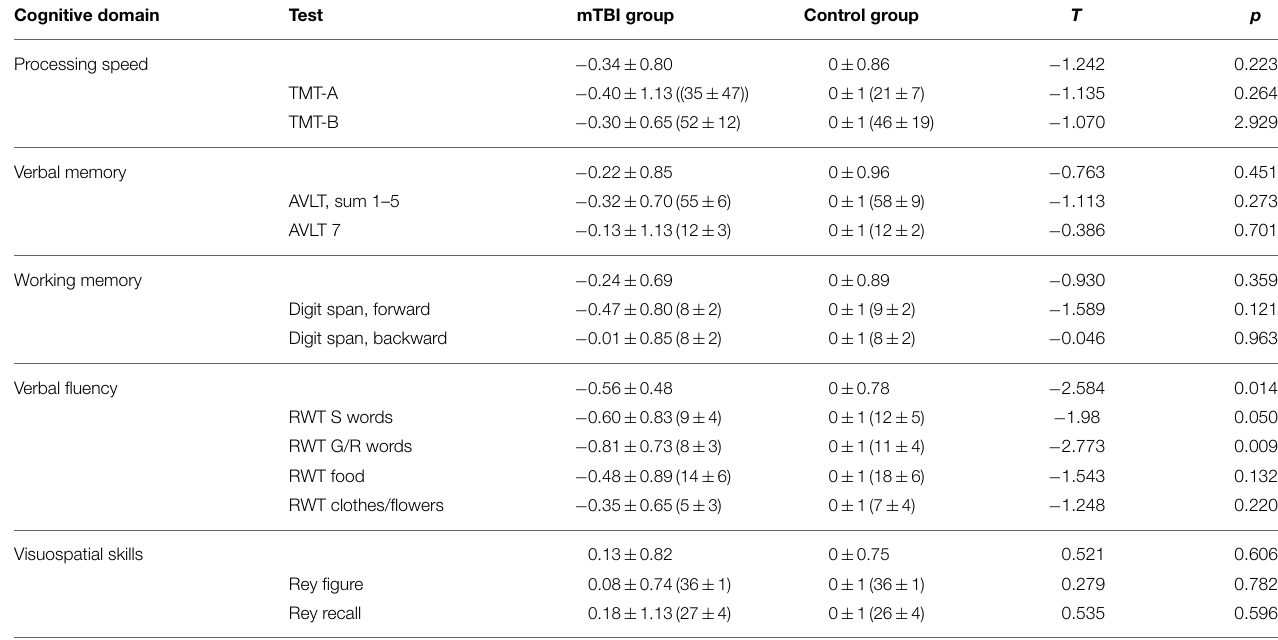
TABLE 2 | Neuropsychological test results of mTBI subjects and control subjects. Cognitive domain